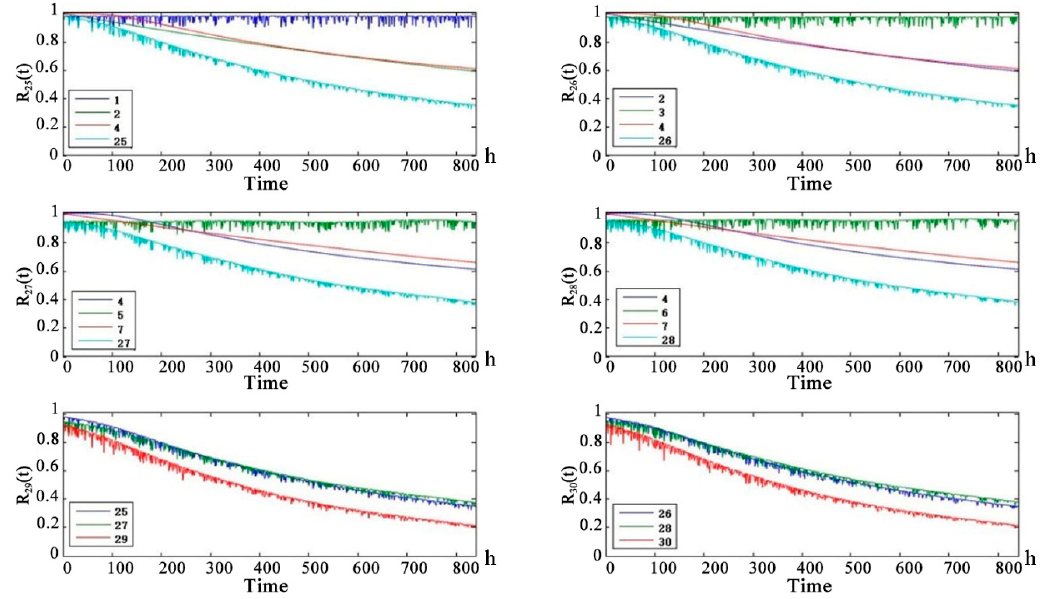
Figure 11. Health state probability prediction curve of Solar-powered UAV data-link intermediate node future 840 h.